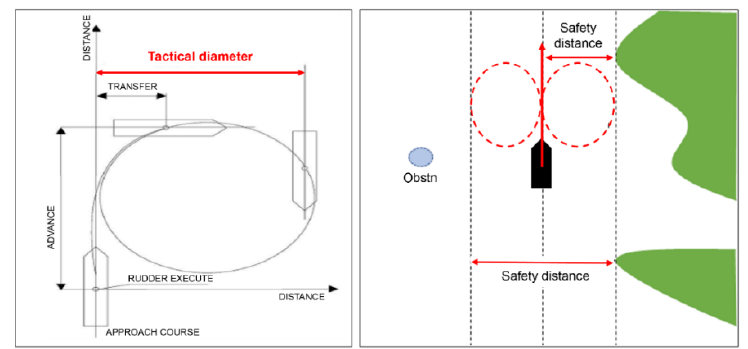
Figure 9. Safety distance using the tactical diameter.